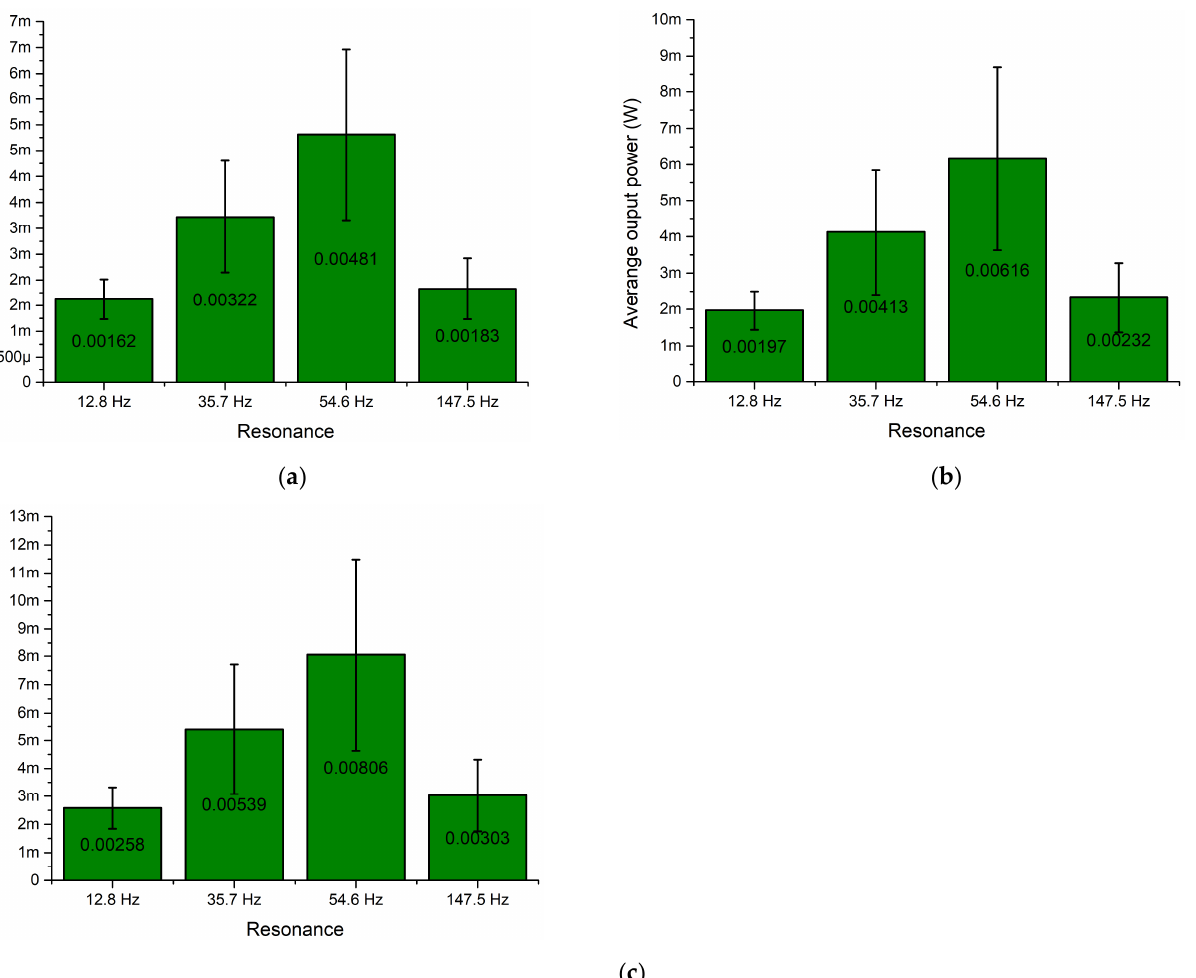
Figure 23. Summary of average output power at resonance frequencies while different loads are used; ( a )—load equal to 1 MΩ; ( b )—load equal to 500 kΩ; ( c )—load equal to 250 kΩ.